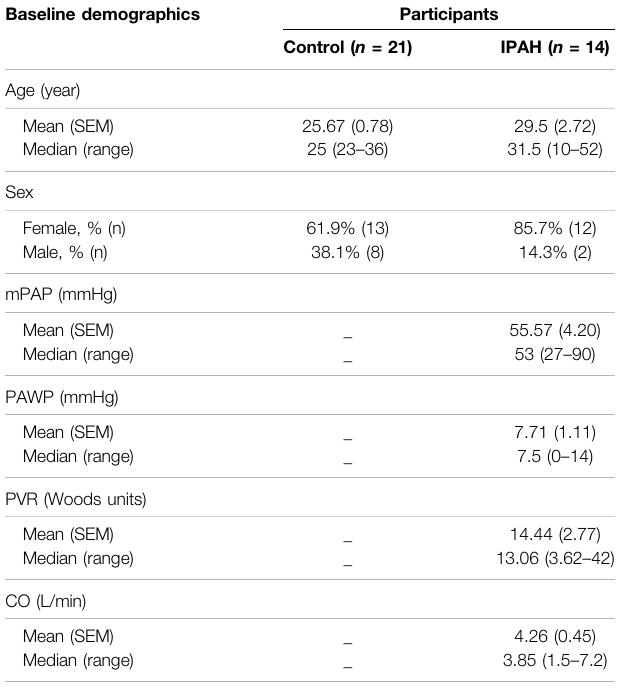
TABLE1| Basicdemographicsofallparticipantsinclinicaltrials.ThemPAP(mean pulmonary arterial pressure), PAWP (pulmonary artery wedge pressure) and PVR (pulmonary vascular resistance) and CO (cardiac output) were measured by the right cardiac catheterization (RHC). The Treatment means that the patient has been treated with targeted drugs for IPAH (idiopathic pulmonary arterial hypertension),beforethe RHC forthe fi rst time at theFirst Af fi liated Hospital of Chongqing Medical